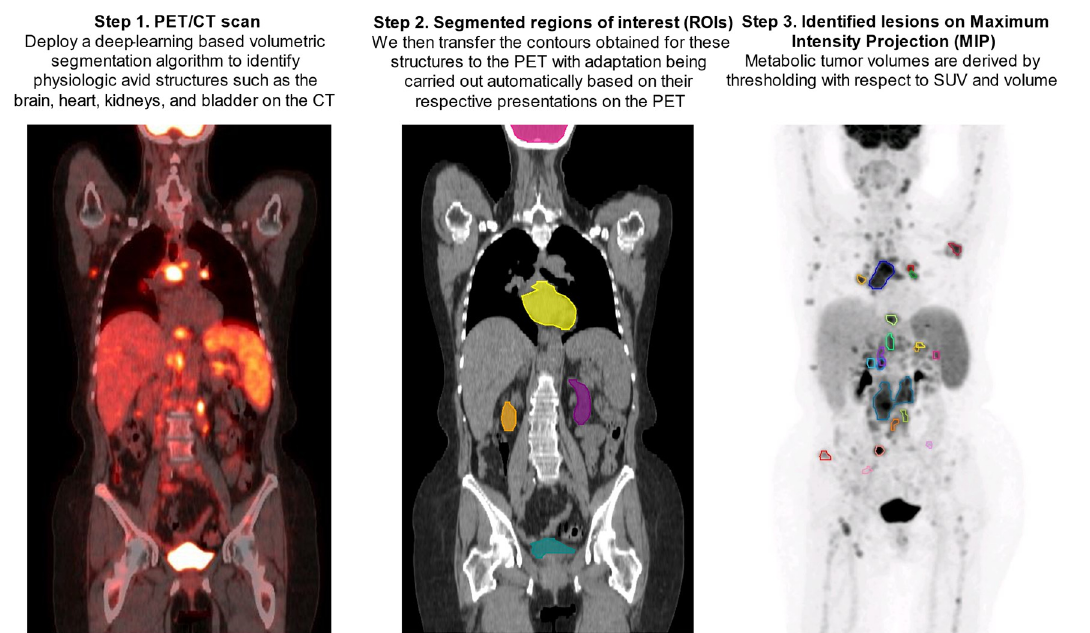
Figure 2. Step-by-step demonstration of deep-learning-aided metabolic tumor volume calculations.